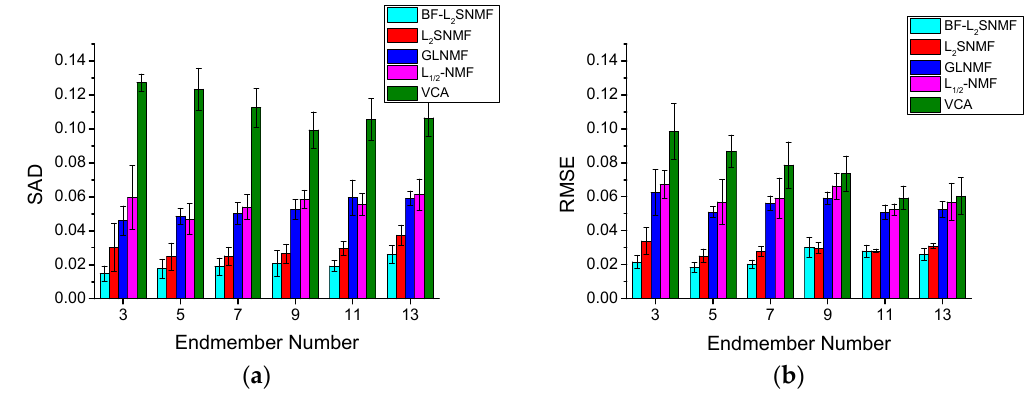
Figure 5. The experimental results for different endmember numbers: ( a ) SAD and ( b ) RMSE.